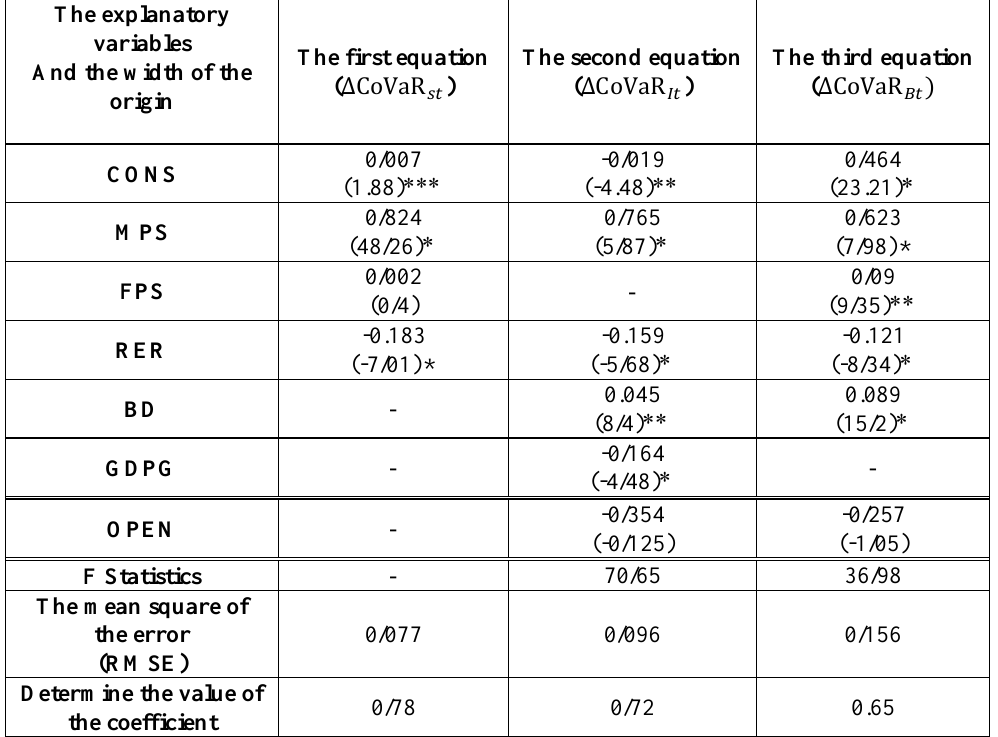
Table 8. Results of estimating pattern equations by seemingly unrelated regression methods